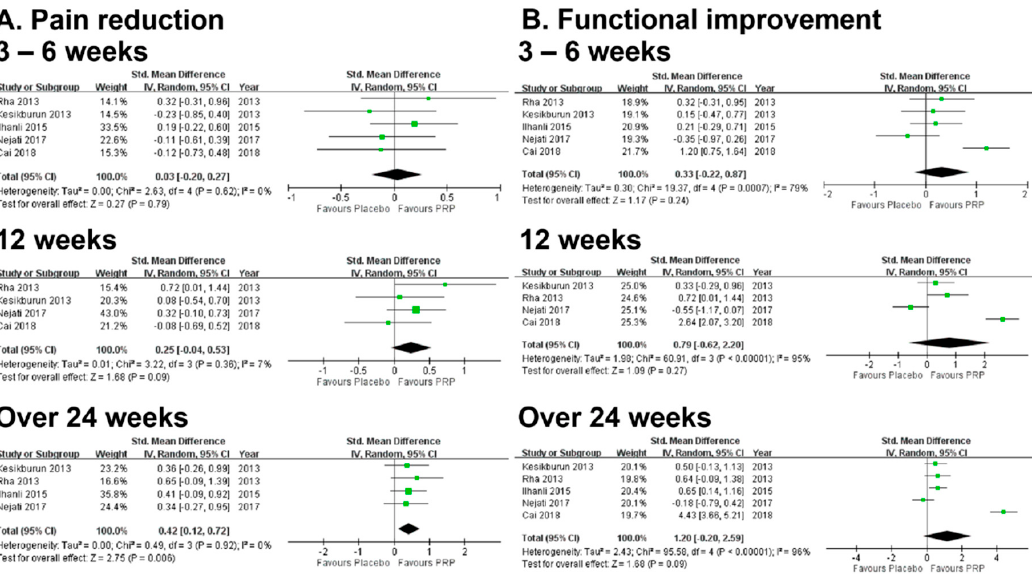
Figure 3. Forest plots of meta-analysis after sensitivity analysis: comparison between PRP injection and the control group in pain reduction ( A ) and functional improvement ( B ) at the short term (3–6 weeks), the medium term (12 weeks), and the long term (over 24 weeks). Abbreviation: PRP, platelet-rich plasma.